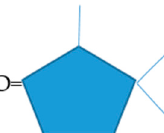
Figure 6. Default carbocyclic structural features that delineate efficacy as a growth substrates for Pseudomonas putida NCIMB 10007. Both the number and positions of the three methyl/methylene bridge substituents relative to the carbonyl group are critical structural determinants of functionality.